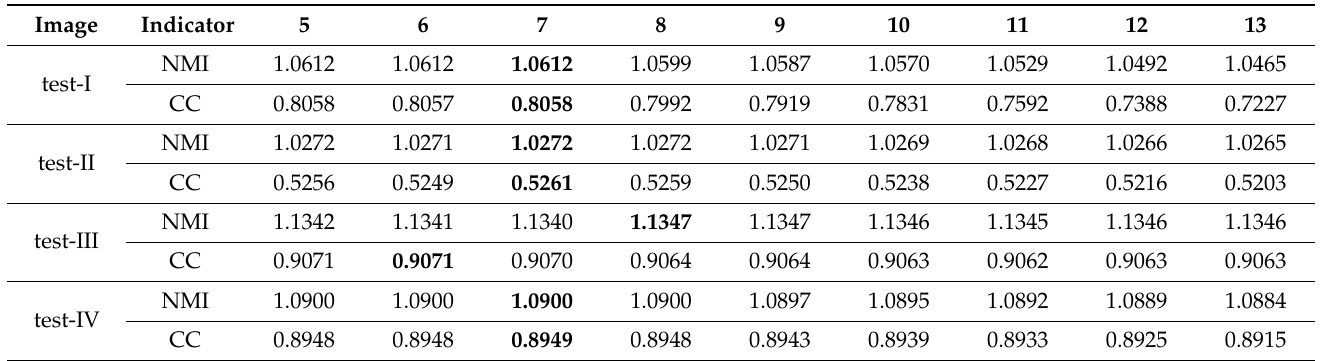
Table 3. Quantitative evaluation of ultimate registration with different T r